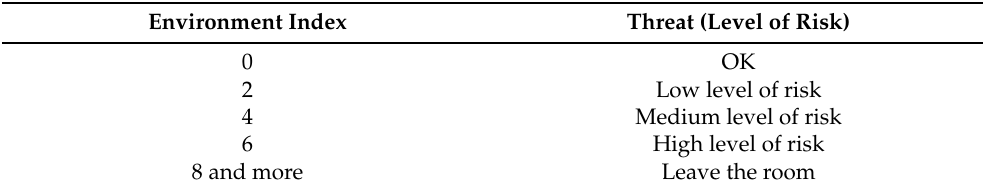
Table 2. Environment index and level of